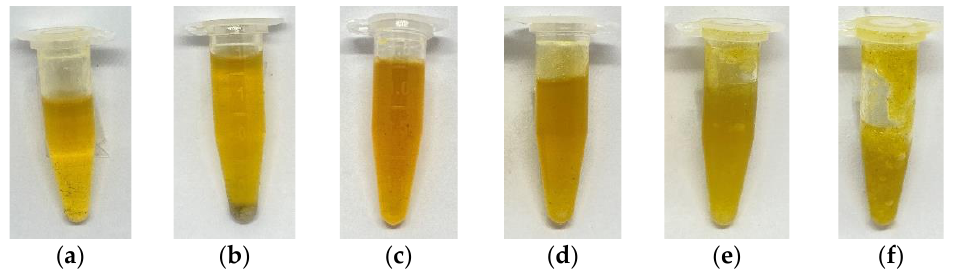
Figure 1. Essential oil at varying percentages of overfilled solvent: ( a ) 0%; ( b ) 10%; ( c ) 20%; ( d ) 30%; ( e ) 40%; ( f ) 50%.